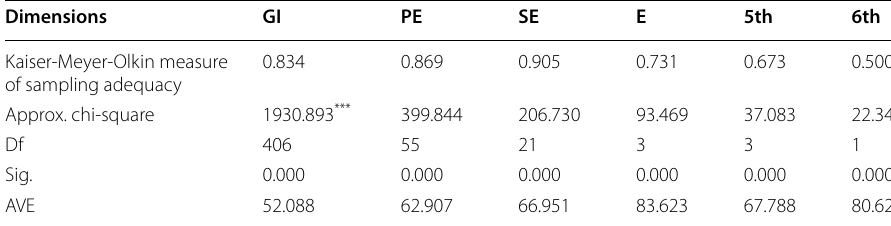
*** Significant at .1%